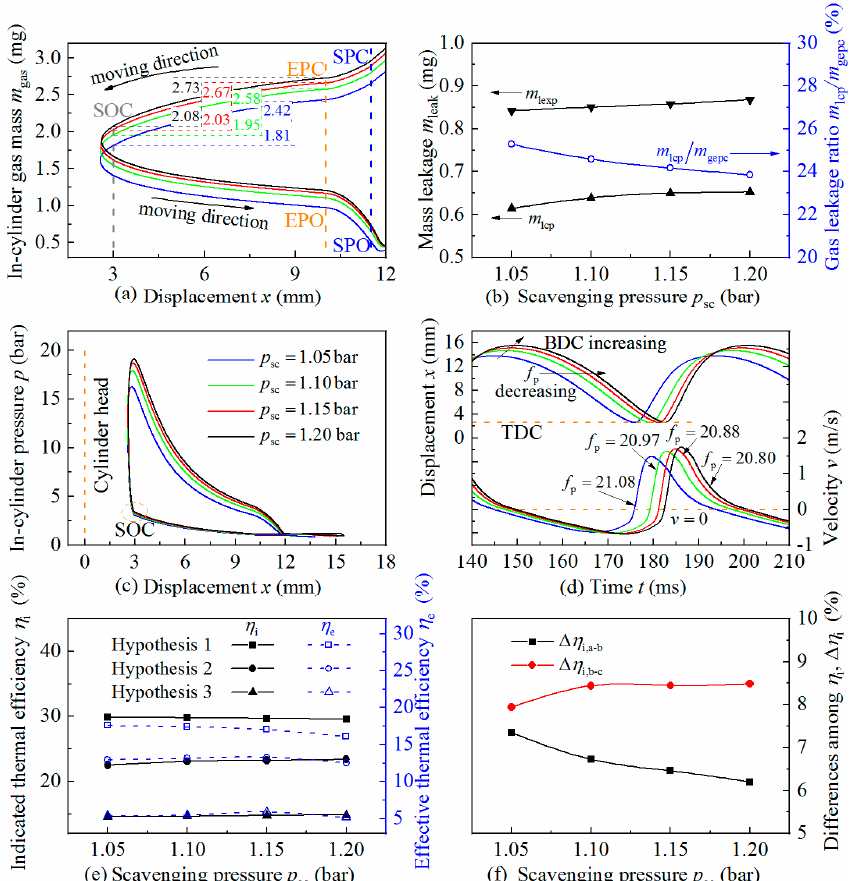
Figure 7. The influence of scavenging pressure on leakage and system performance. ( a ) Mass variations of in-cylinder gas in function of stroke; ( b ) Mass leakage; ( c ) Pressure variations of in-cylinder gas in function of stroke; ( d ) Piston dynamic characeristics; ( e ) Thermal efficiencies; ( f ) Indicated thermal efficiency drops. Figure ( a , c , d ) apply the same legend displayed in figure ( c ). The blue, green, red and black solid lines stand for the scavenging pressures at 1.05, 1.10, 1.15 and 1.20 bar, respectively. The values in figure ( a ) show the exact amount of the in-cylinder gas mass at the corresponding positions. The symbol f p in figure ( d ) stands for piston frequency,